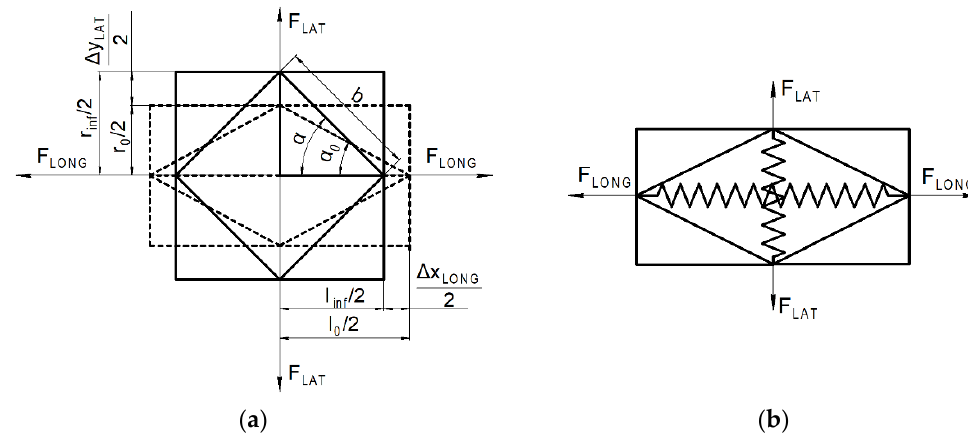
Figure 1. The cell of the mesh shell of the pneumatic muscle: ( a ) changed geometrical dimensions before (dashed line) and after pressure supply (solid line); ( b ) cell with springs.